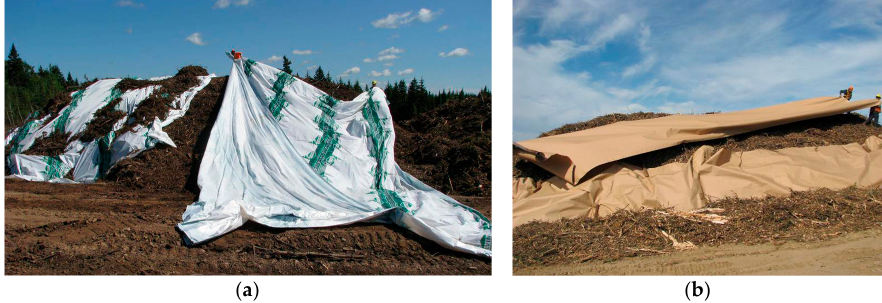
Figure 4. Tarping operation using, ( a ) plastic-based tarp and ( b ) paper-based tarp.